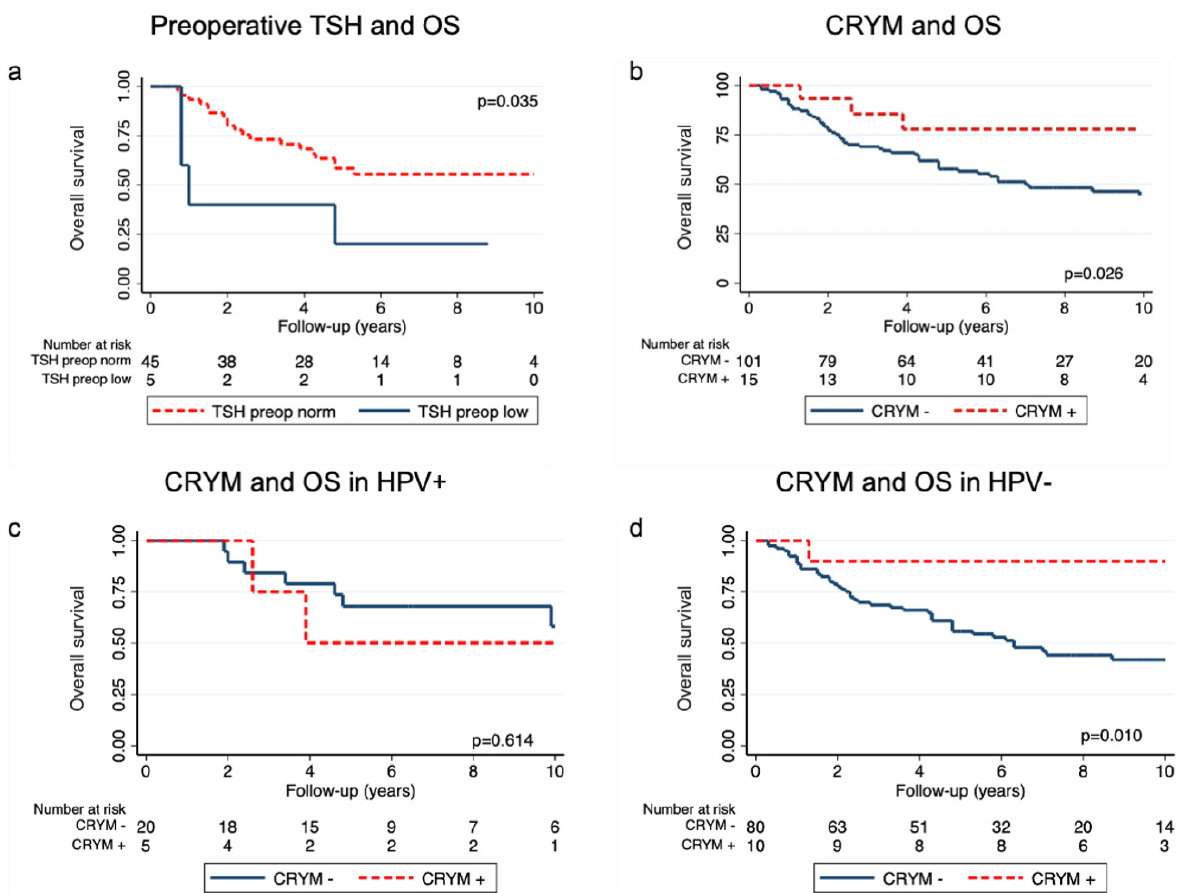
Figure 1. Kaplan–Meier curves for OS according to preoperative TSH levels ( a ), CRYM expression ( b ) and CRYM expression separated for HPV+ ( c ) and HPV − ( d ) patients.